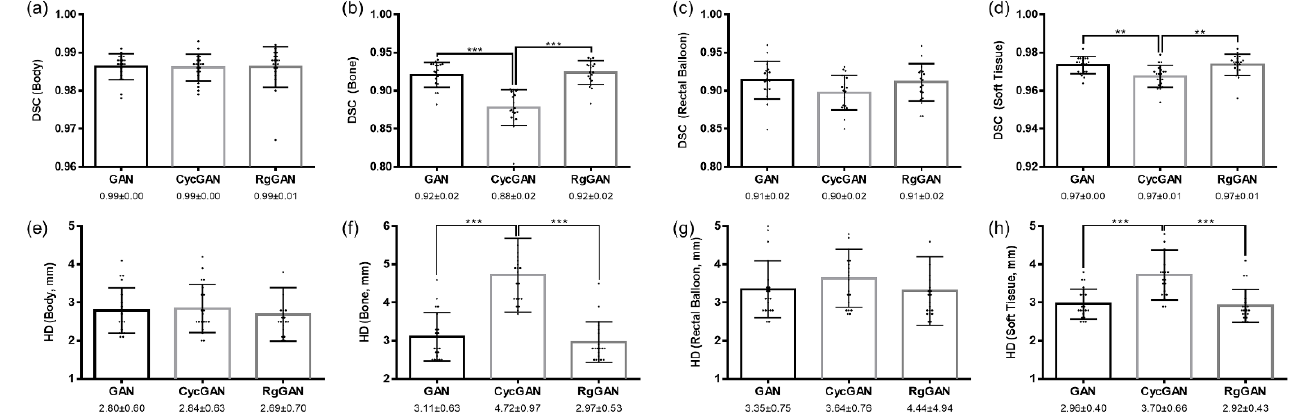
Figure 4. Comparison of dice-similarity coefficients for body ( a ), bone ( b ), rectal balloon ( c ), and soft tissue ( d ) and Hausdorff’s distance (HD) for body ( e ), bone ( f ), rectal balloon ( g ), and soft tissue ( h ) in synthetic computed tomography according to the deep learning techniques . Abbreviations: DSC, dice-similarity coefficient; GAN, generative adversarial network; CycGAN, cyclo-consistent generative adversarial network; RgGAN, Reference-guided cyclo-consistent genera- tive adversarial network; HD, Hausdorff distance. * 0.01 < p < 0.05, ** 0.001 < p < 0.01, *** p < 0.001.